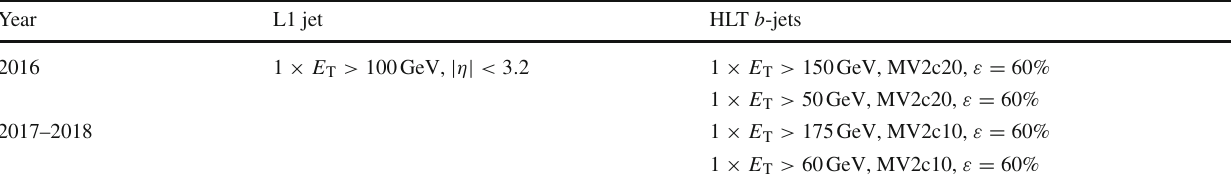
Table 3 Details, by year, of the lowest-threshold unprescaled di- b -jet triggers. The minimum ( b -)jet E T , | η | , and b -tagging requirements are specified for each item. HLT b -jets are required to be within | η | < 2 . 5.